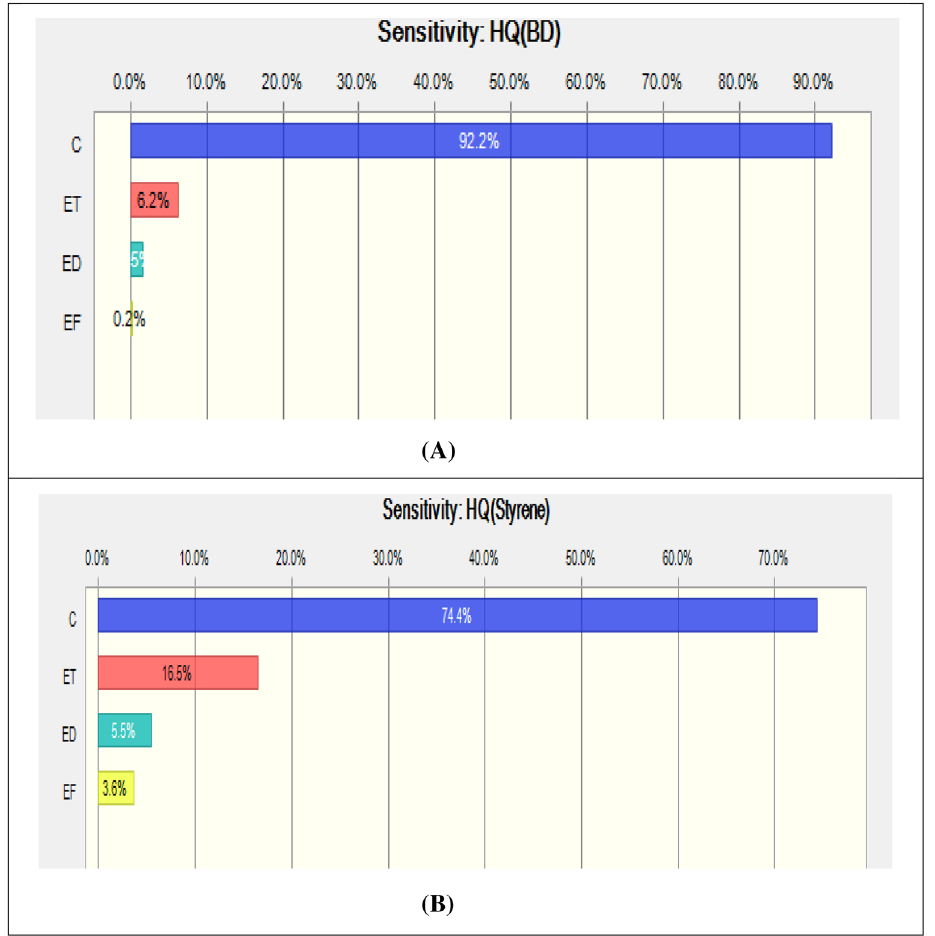
Figure 4. Sensitivity analysis of the non-cancer risk (HQ) for ( A ) 1,3-butadiene, ( B )